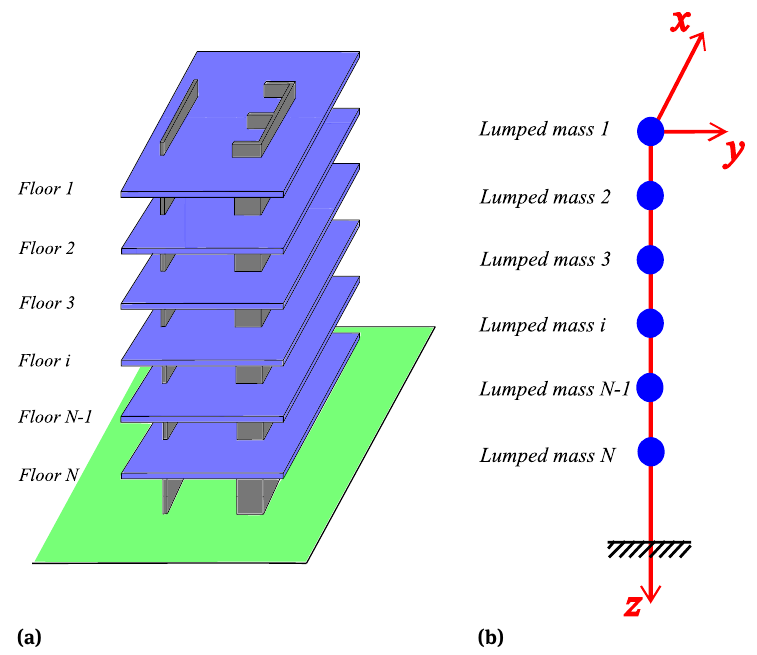
Figure 1: (a) 3D-model of the building; (b) Equivalent cantilever beam with lumped